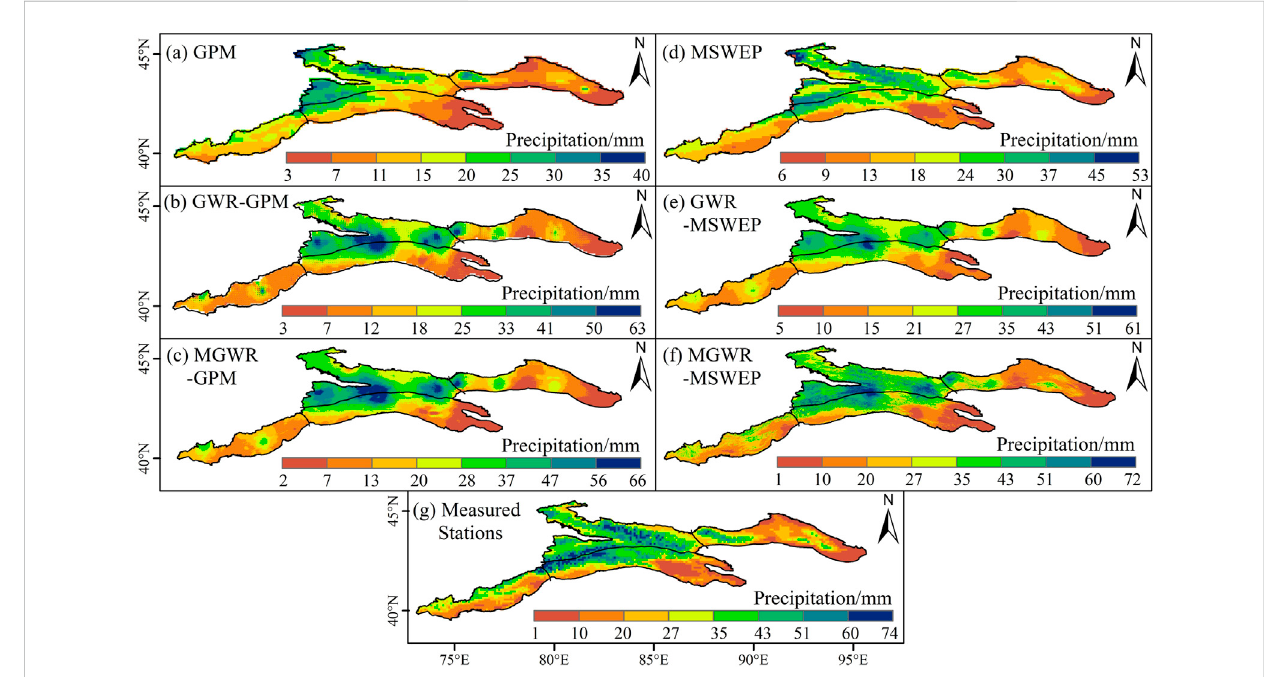
FIGURE 7 Spatial distribution of satellite products, downscaling results and interpolation of monthly precipitation in Tianshan Mountains (A) GPM; (B) GWR- GPM; (C) MGWR-GPM; (D) MSWEP; (E) GWR-MSWEP; (F) MGWR-MSWEP; (G) Measured